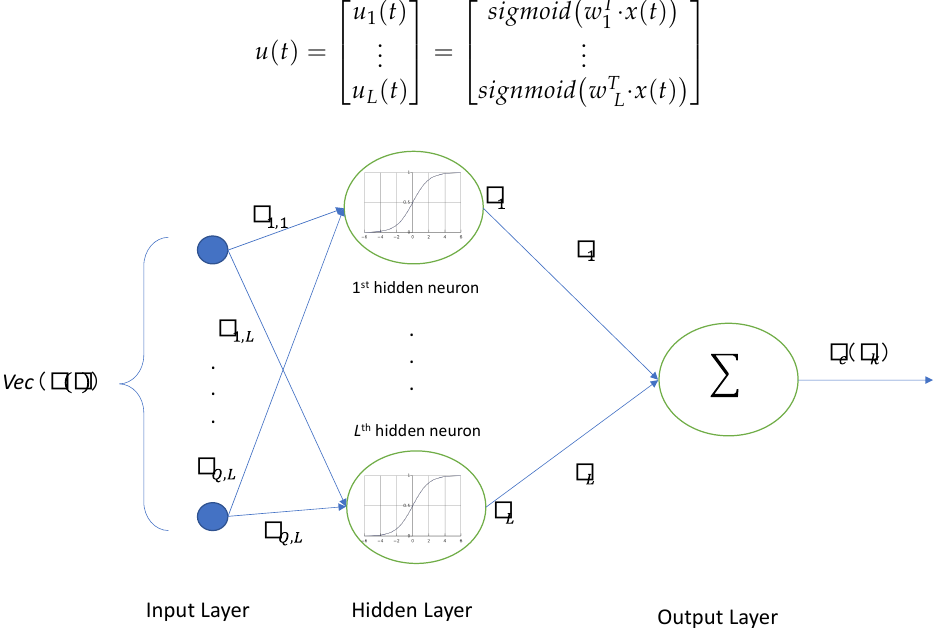
Figure 2. The structure of a feedforward neural network of one hidden layer of L neurons.